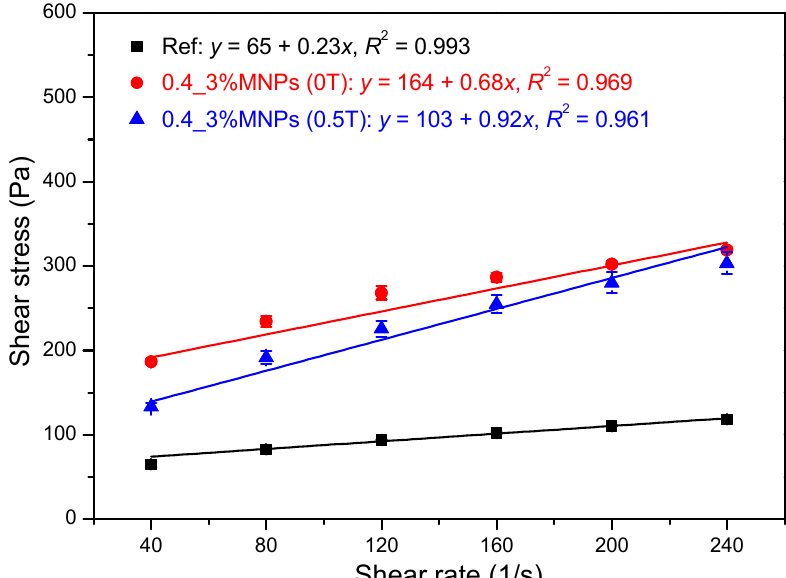
Figure 7. Effect of magnetic field on the flow curve of cementitious pastes. Figure 7. E ff ect of magnetic field on the flow curve of cementitious